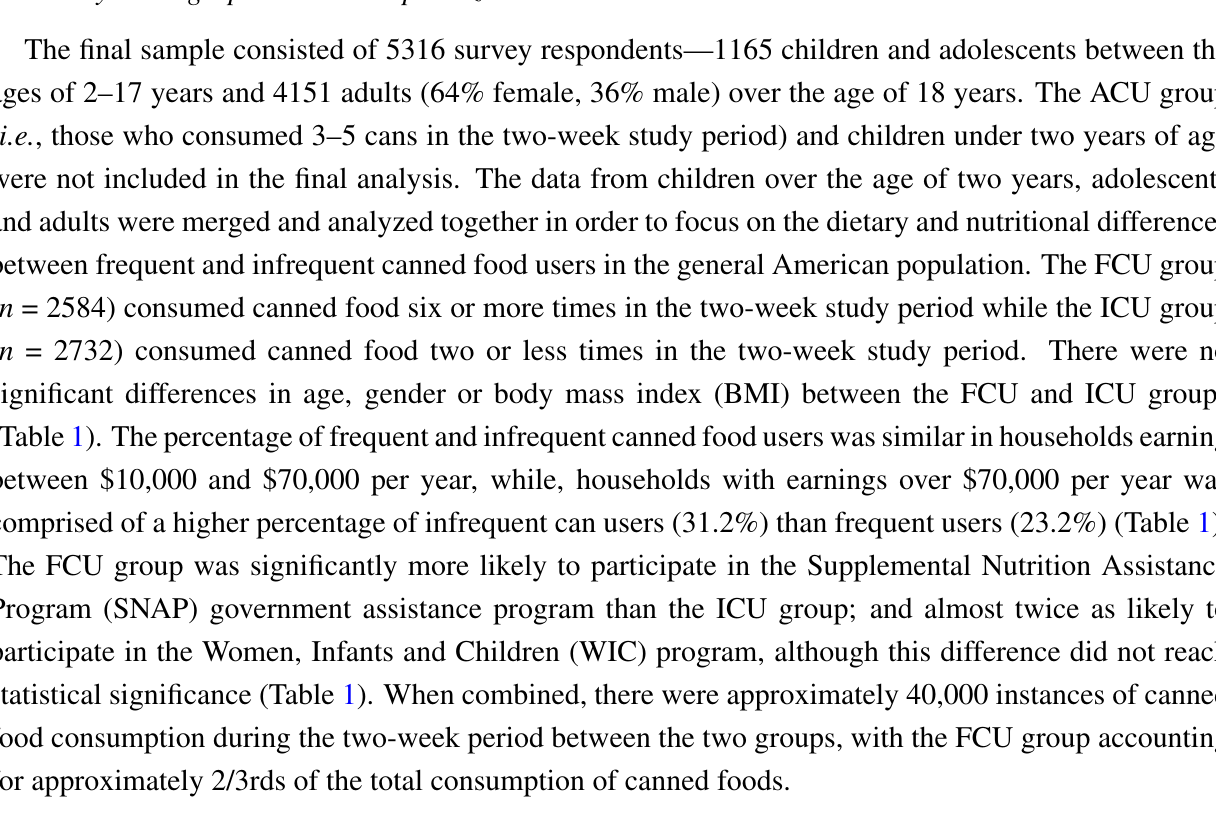
Table 1. Demographics of frequent and infrequent canned food